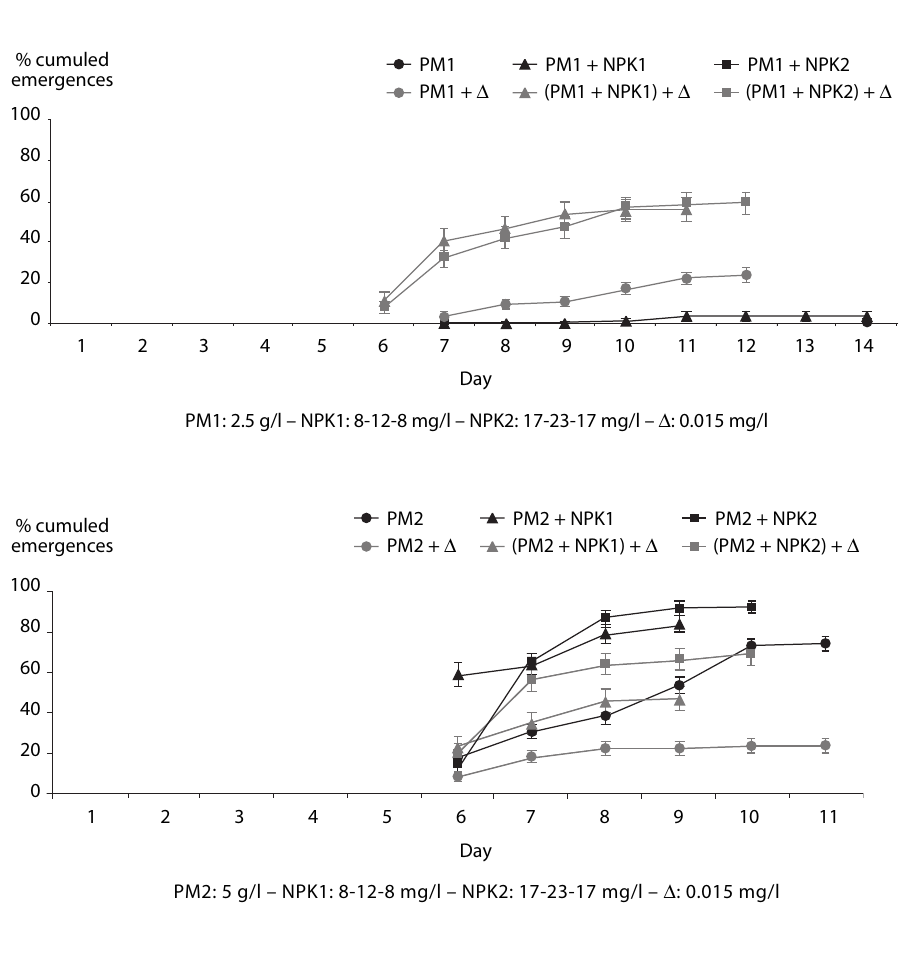
T HE POPULATION DYNAMICS OF A N . GAMBIAE KIS STRAIN IN ACCORDANCE WITH THE ENVIRONMENTS Deltamethrin at the concentration of 0.015 mg/l killed 100 % of the larvae of An. gambiae KIS susceptible to pyrethroids whatever the environment. D ELTAMETHRIN SUSCEPTIBILITY OF FEMALES Table I. – Activity of deltamethrin at a discriminating dosage OF A N . GAMBIAE VKPR AND KIS STRAINS (0.05 % = 18,4 mg/m 2 ) against the pyrethroid-resistant strain of The bioassays were carried out with adult females Anopheles gambiae (VKPR) and the insecticide-susceptible strain of An. gambiae (KIS). from untreated habitats. Due to the very small indi- viduals collected in PM1 environments, the tests were only performed with the adults emerging from PM2, PM2 + NPK1 and PM2 + NPK2 environments (Table I). Compared to susceptible KIS, VKPR strain Environment confirmed its high level of resistance to pyrethroids and PM2 + NPK2 demonstrated a susceptibility to delta- methrin similar to PM2 (respectively P = 0.98 and P = 0.27). A VERAGE WEIGHTS AND PROTEIN CONTENTS The average weight and the dosage of soluble pro- Table II. – Average weights and soluble protein contents in females teins were measured on the females emerging from of Anopheles gambiae VKPR strain. Original contribution